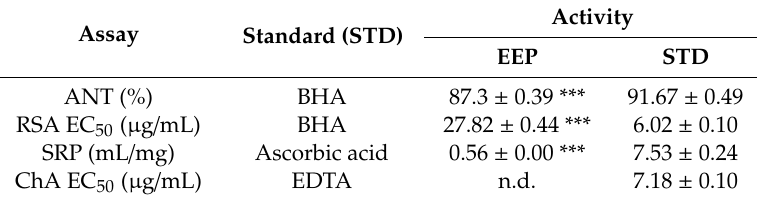
Table 2. Radical scavenging activity (RSA EC 50 ), slope of reducing power trendline (SRP), activity in β -carotene-linoleate assay (ANT), and metal chelating activity (ChA EC 50 ) of ethanol extract of and propolis and standards. Assay